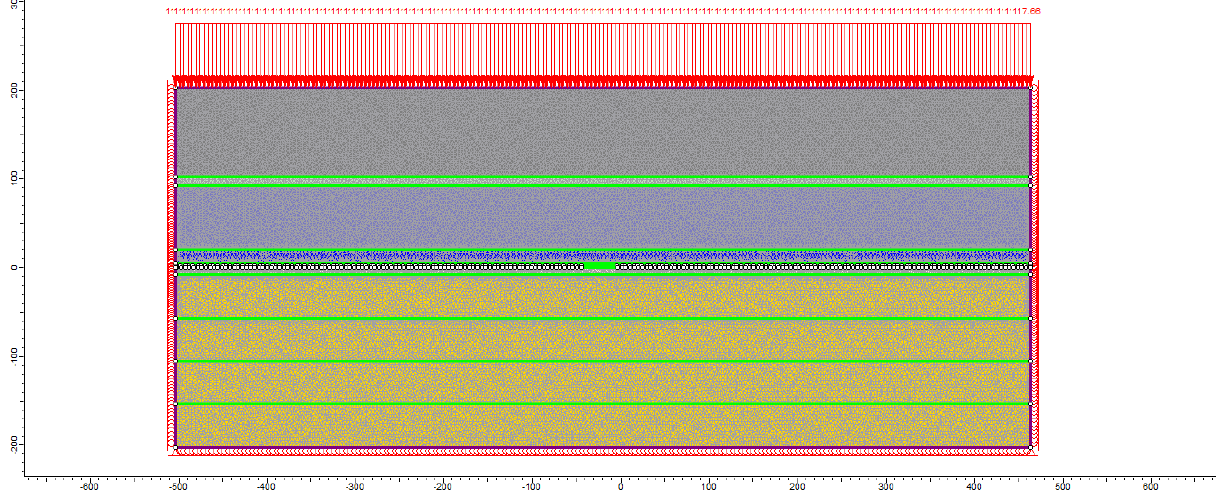
Figure 7. Numerical model for the analyzed region.